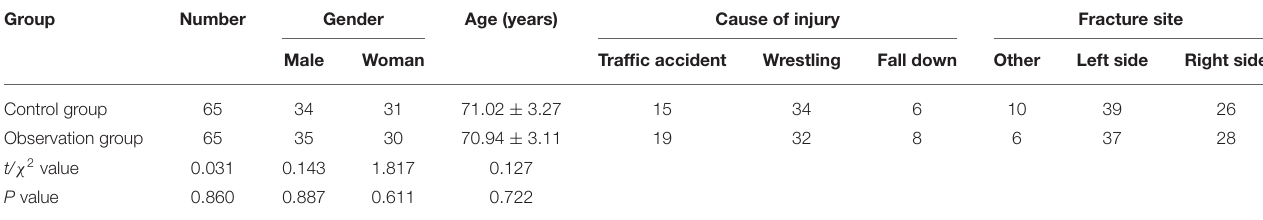
TABLE 1 | Comparison of general information of two groups of patients. Group Number Gender Age (years) Cause of injury Fracture site Male Woman Traffic accident Wrestling Fall down Other Left side Right side Control group 65 34 Observation group